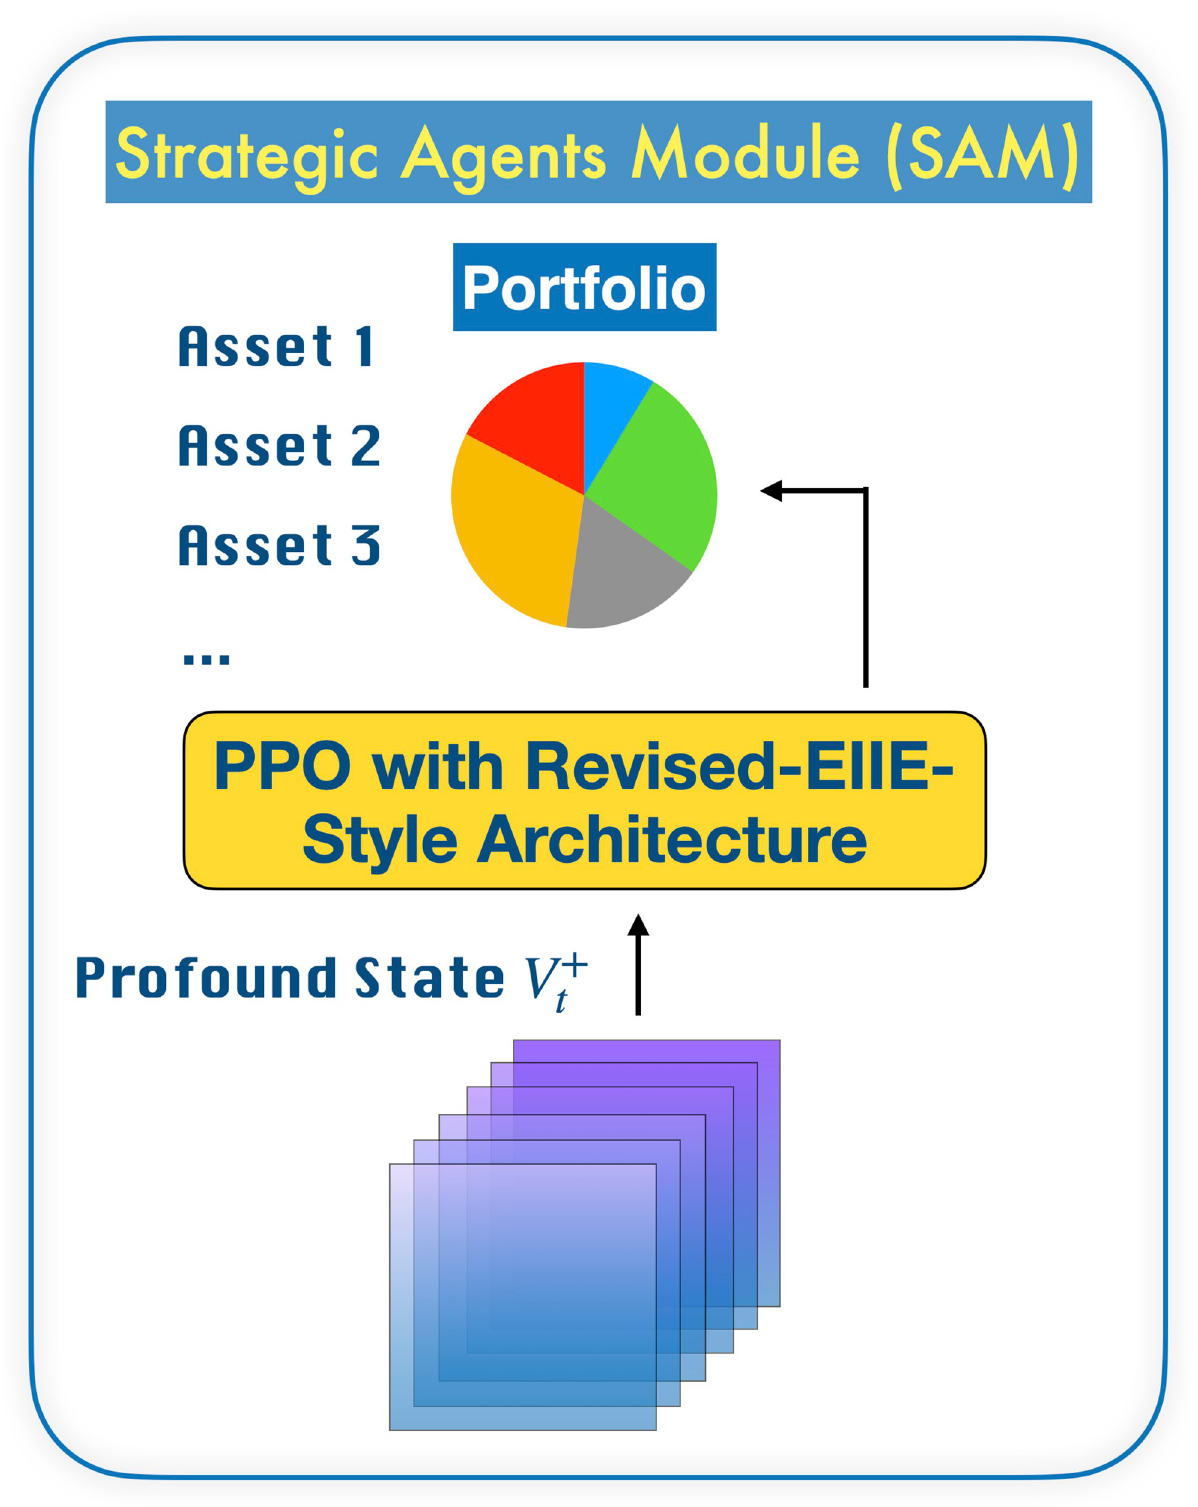
Fig 4. Abstract of SAM’s architecture. An SAM is a module for an investment portfolio. The input of SAM, profound state V þ tensor, where f is the number of features, m � = m + 1 is the number of assets m in the portfolio plus cash and n is the fixed rolling-window length. Each SAM takes the profound state V þ which is stacked and transformed from 2-D tensors from connected EAMs, and further generates the reallocation t weights for the assets in the portfolio.